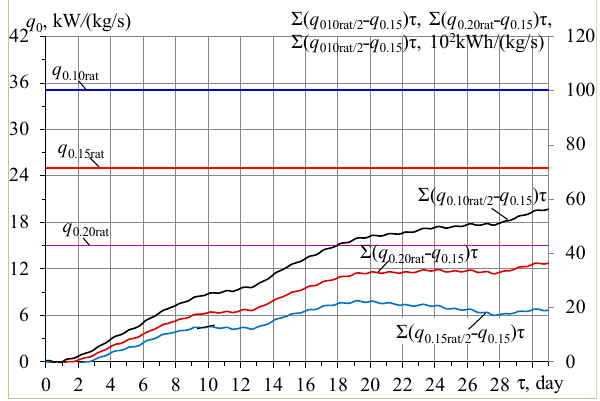
Figure 10. Rational values of refrigeration capacities q 0.10rat , q 0.15rat , and q 0.20rat for conditioning outdoor air to 10 ° С , 15 ° С , and 20 ° С , respectively, and summarized monthly refrigeration energy exceed-